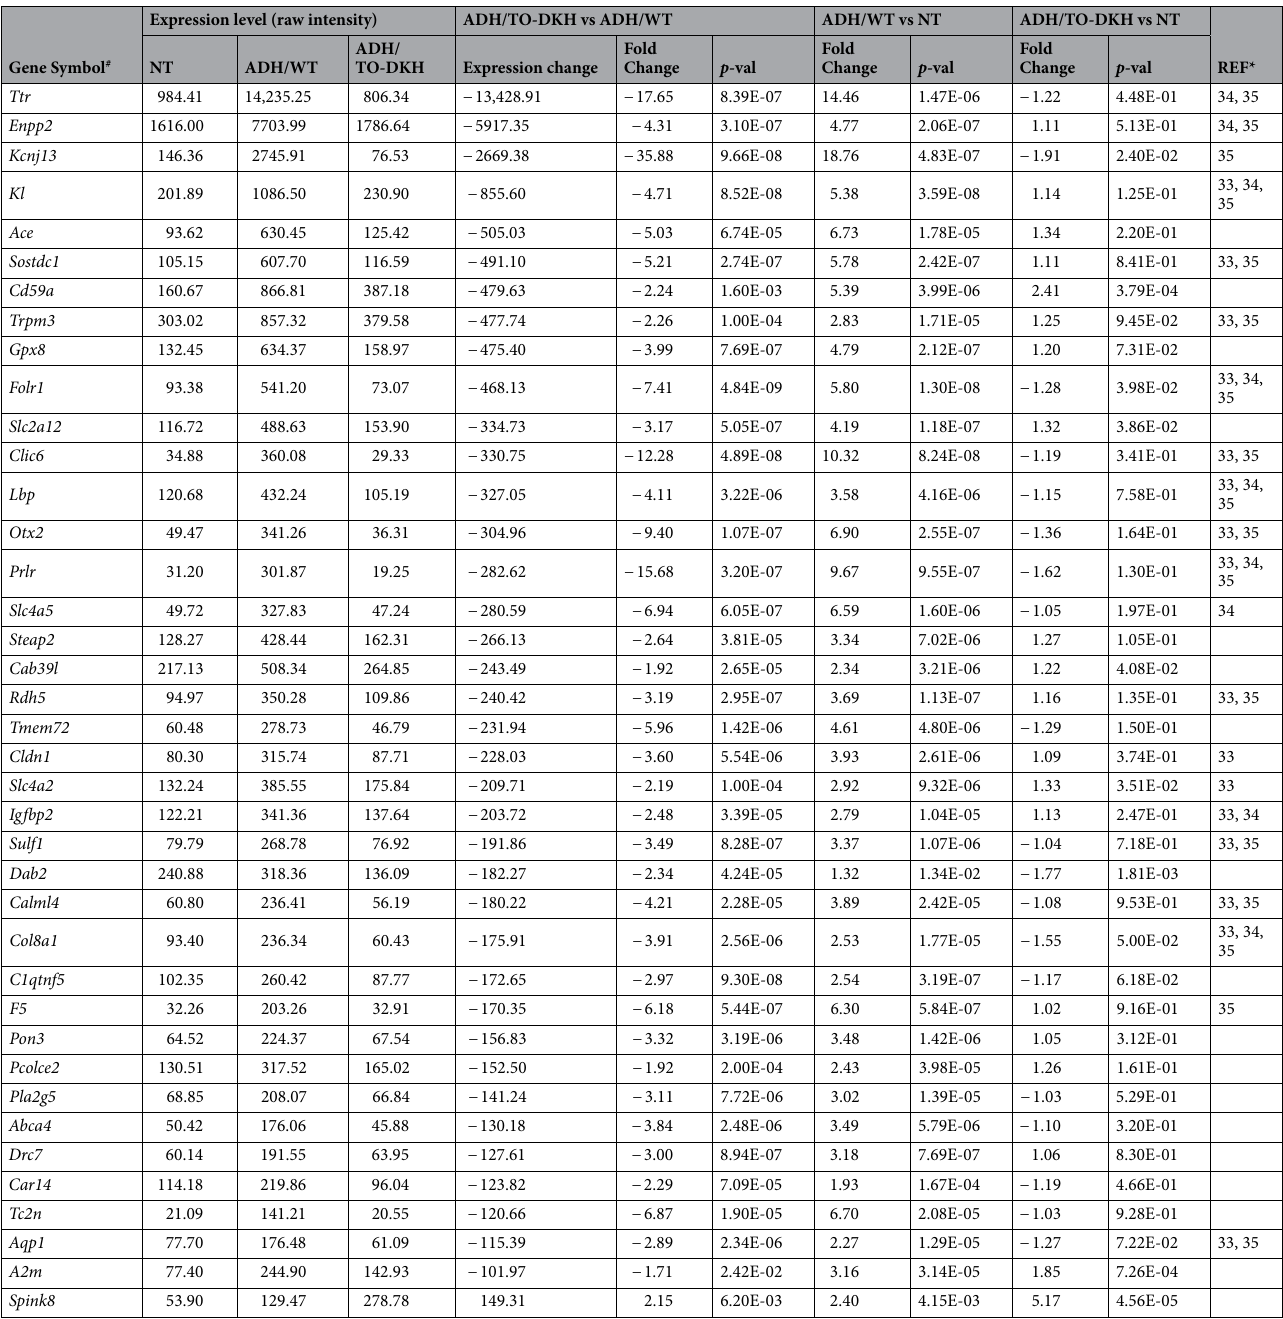
Table 1. List of genes with significantly different expression between ADH/TO-DKH and ADH/WT hippocampi. Genes with significantly different expression between ADH/WT and ADH/TO-DKH hippocampi are shown in order of expression change between the two groups, with comparison to data from NT (eBayes ANOVA: false discovery rate [FDR] p < 0.05, fold-change > 1.5 or < − 1.5, highest raw intensity among three groups > 100). *Altered expression of the corresponding gene was reported in hippocampus prepared from different mouse lines carrying neuron-specific enolase/human Tau23 transgene 33 , APP swe transgene 34 or neuronal conditional deletion of App and Aplp 2 35